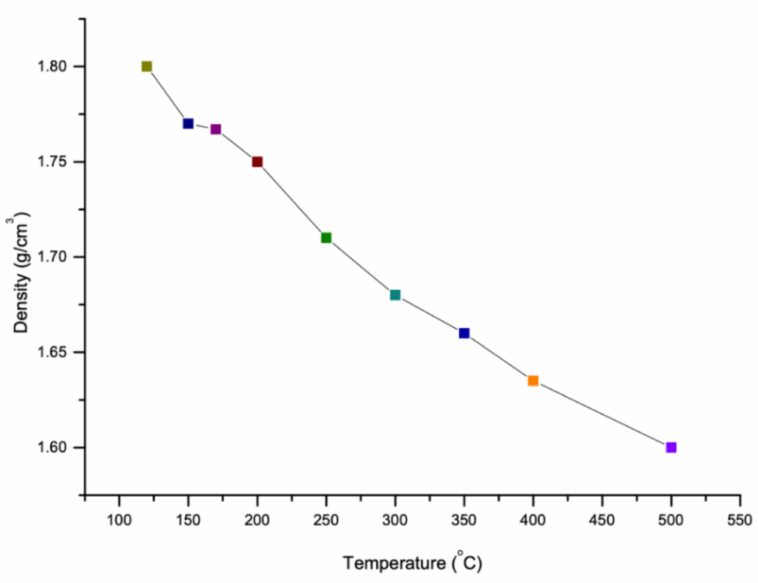
Figure 6. Density of sulfur in accordance with temperature and allotropes (data extracted from References [15,36,69,79–86].